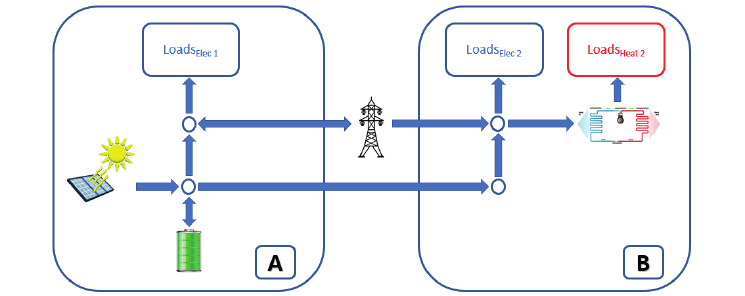
Fig. 2. Schema of the REC used to illustrate the test case